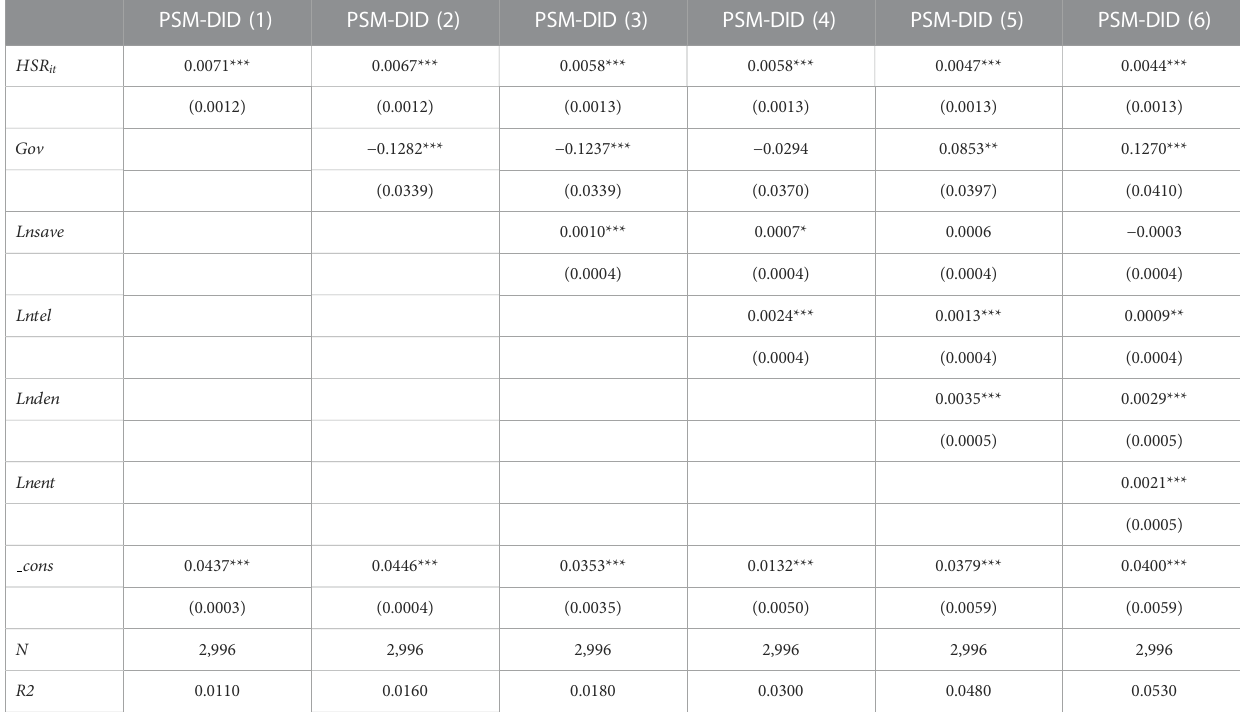
TABLE 8 Robustness test results for calculating high-quality development by replacing GDP with nighttime light